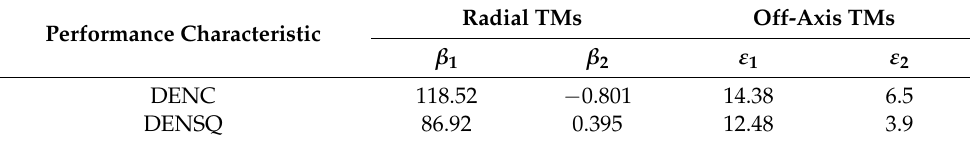
Table 9. Encircled Energy Characteristic Fit Coefficients.